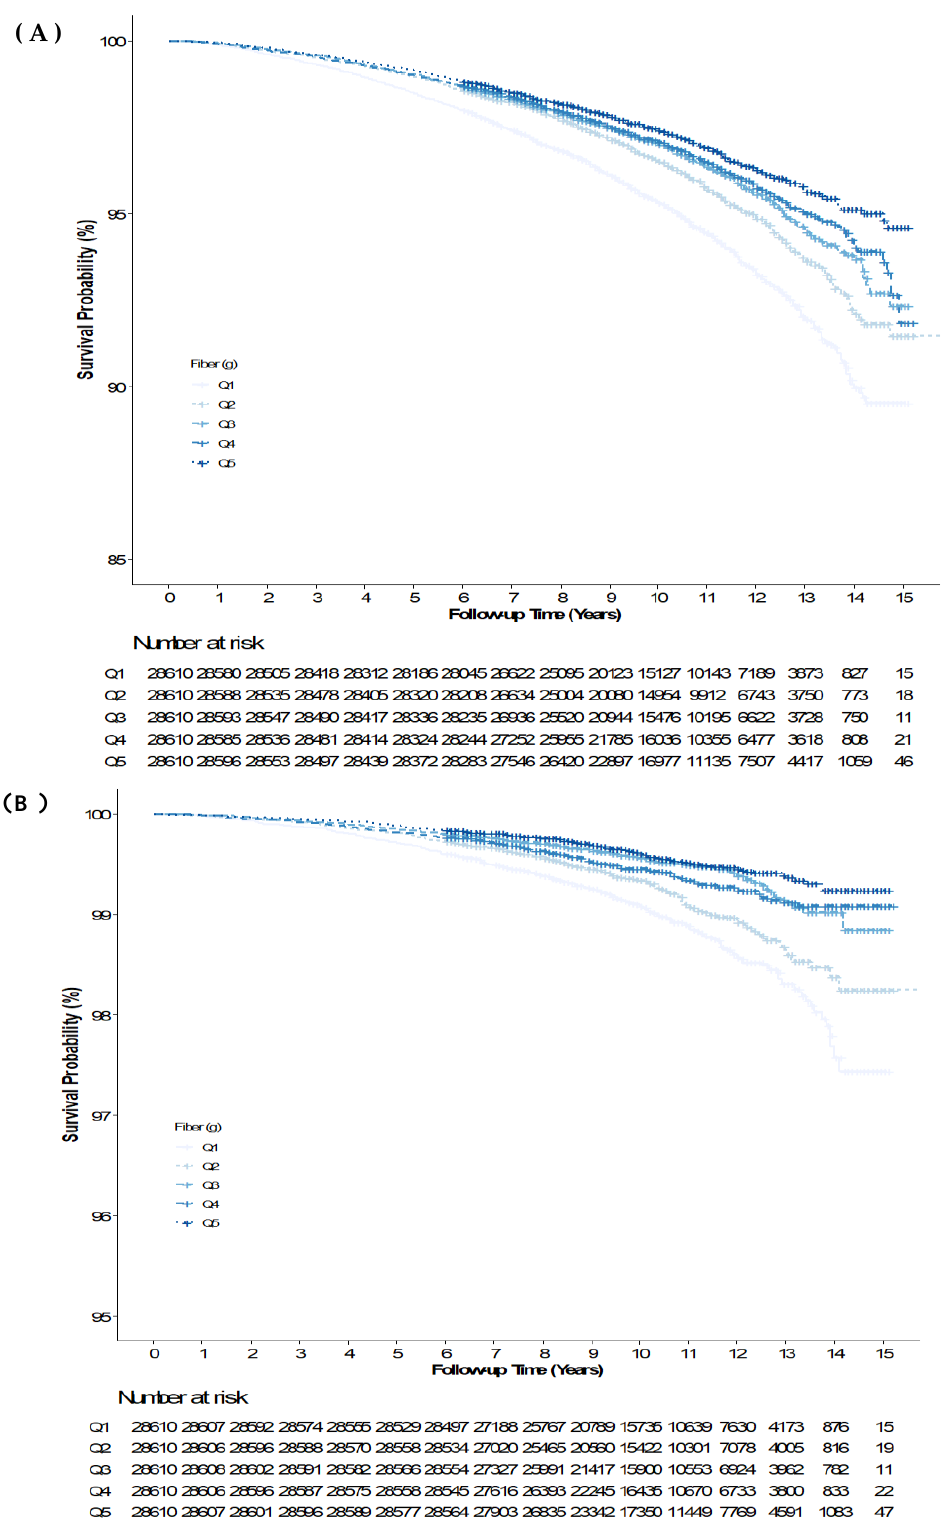
Figure 2. Kaplan–Meier curves displaying the estimated survival probability for fiber intake quintile groups. ( A ) All-cause mortality across the dietary fiber quintiles. ( B ) Cardiovascular disease mortality across the dietary fiber